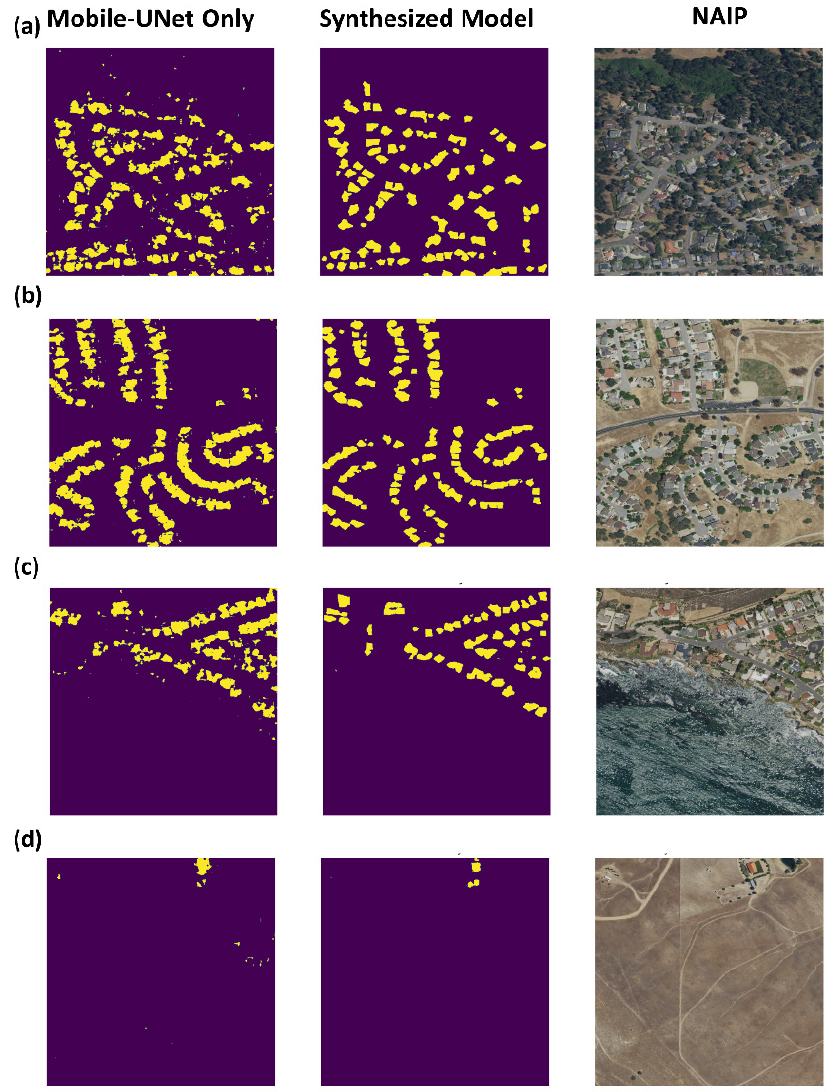
Figure 4. Building footprints detected by Mobile-UNet ( left ) and the synthesized approach ( middle ), respectively, over example areas with dense human settlements ( a , b ) and sparse human settlements ( c , d ). The original true color NAIP imagery from the testing set is also shown as a reference ( right ).